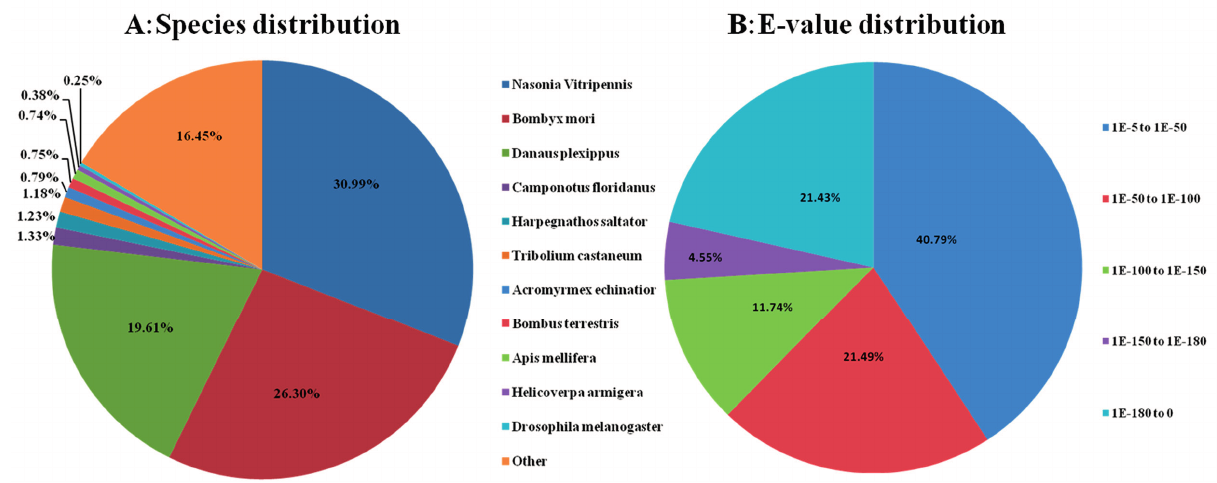
Figure 1. Characteristics of homology search of Illumina sequences against the non-redundant (nr) database. ( A ) Species distribution is shown as the percentage of the total homologous sequences (with an E -value ≤ 1.0 × 10 − 5 ); ( B ) E -value distribution of BLAST hits for each unique sequence with a cut-off E -value of 1.0 × 10 − 5 . We used all